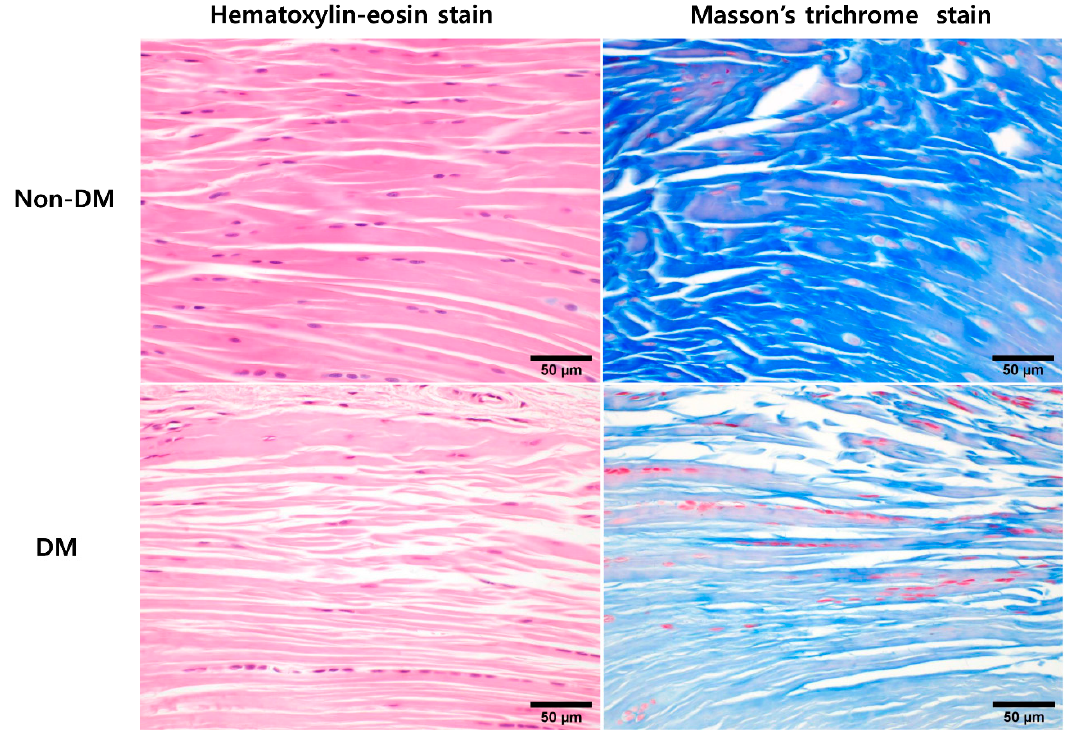
Figure 1. Comparison of histological analysis of supraspinatus tendon harvested from the diabetic (DM) and non-DM groups 12-week after STZ treatment. DM group showed slightly decreased cellularity of tenocytes, thinner fiber thickness with larger interfibrillar spaces and poorly organized collagen fibers compared to non-DM group. Masson’s trichrome staining showed more densely blue-stained collagen bundles in non-DM group compared to that of DM group.